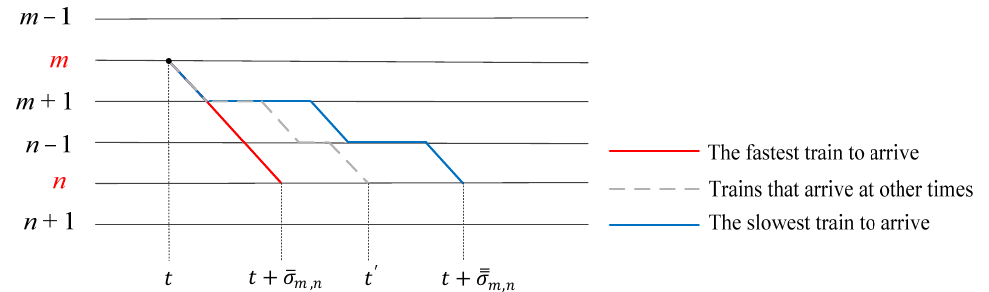
Figure 4. Schematic diagram of OD train service.